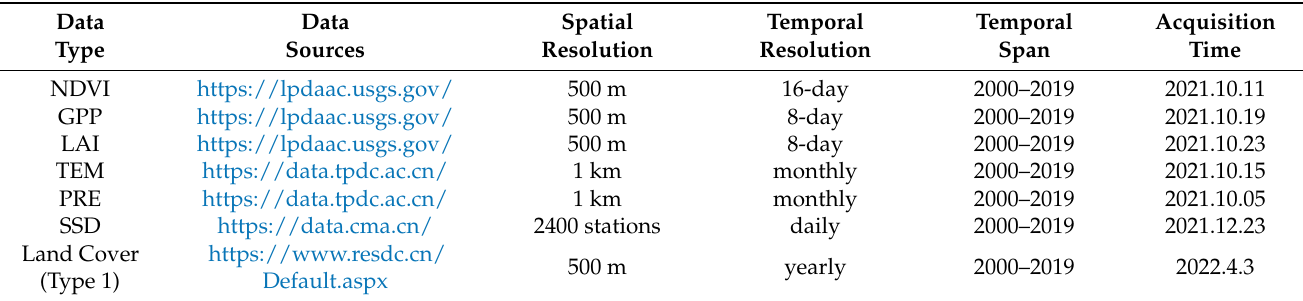
Table 2. Main data used in this